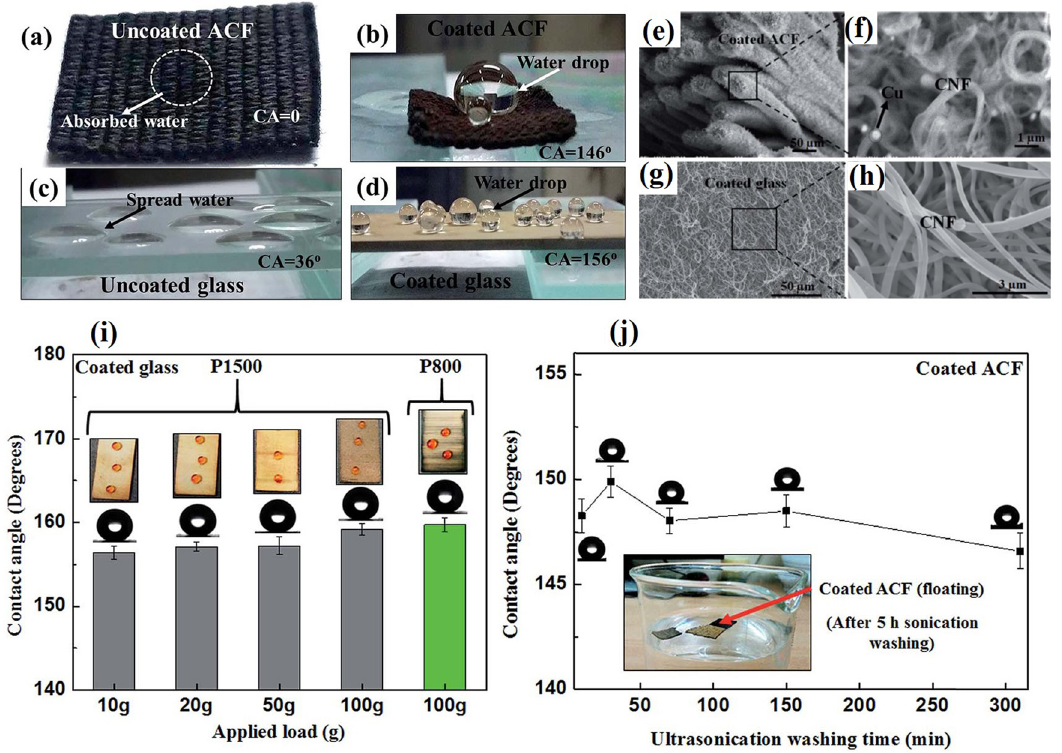
Figure 11: Digital images of ( a ) uncoated CFs, ( b ) coated CFs, ( c ) uncoated glass, and ( d ) coated glass surfaces. SEM images of ( e and f ) coated CFs and ( g and h ) coated glass surfaces. CAs of the coated glass after ( i ) abrasion and ( j ) ultrasonication tests [ 248 ] . Reproduced with permission from ref. [ 248 ] ; © 2017 The Royal Society of Chemistry.